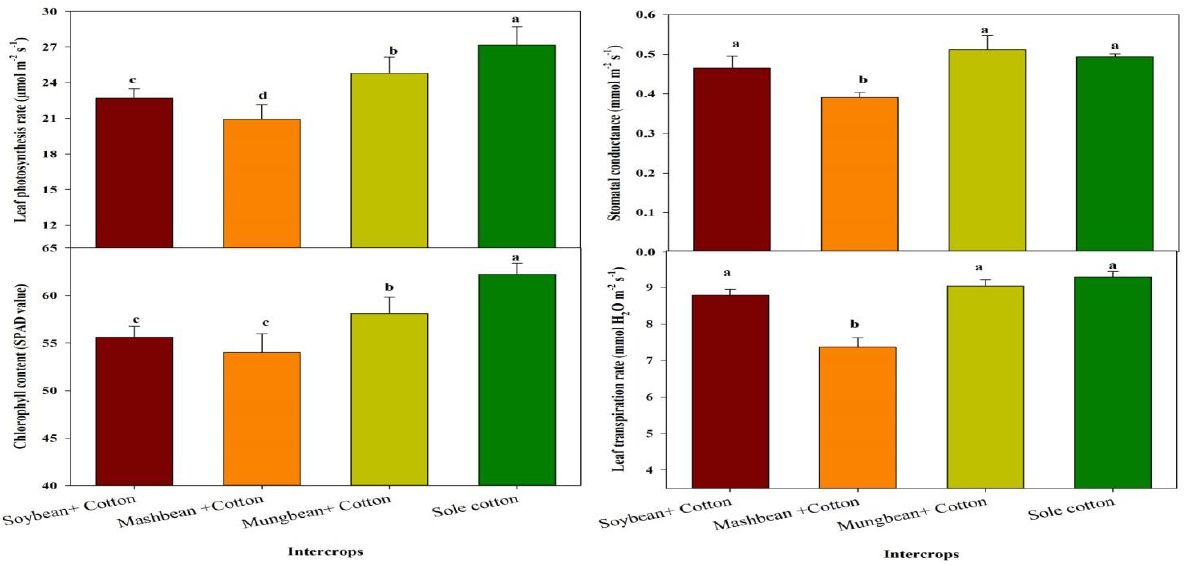
Figure 3. Effect of different legume intercrops on physiological attributes of the cotton crop under arid climatic conditions (tillage systems did not significantly affect the physiological attributes of the cotton crop at ≤ 0.05, hence, data are presented in Table 1). (Letters on graph bars “ a – d ” showed significant differences at p ≤ 0.05)